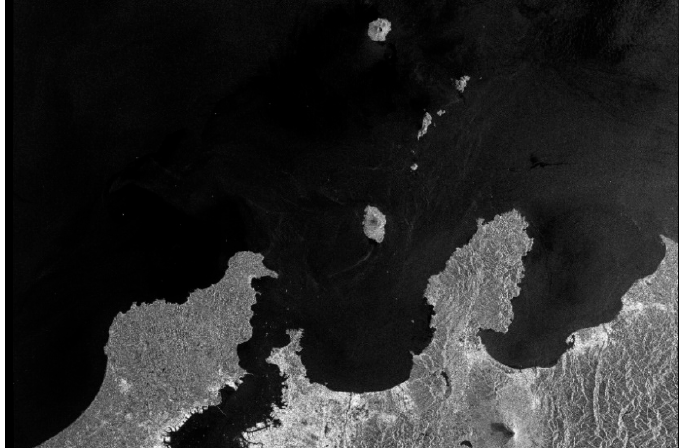
Figure 7. A sample image of LS-SSDD-v1.0.